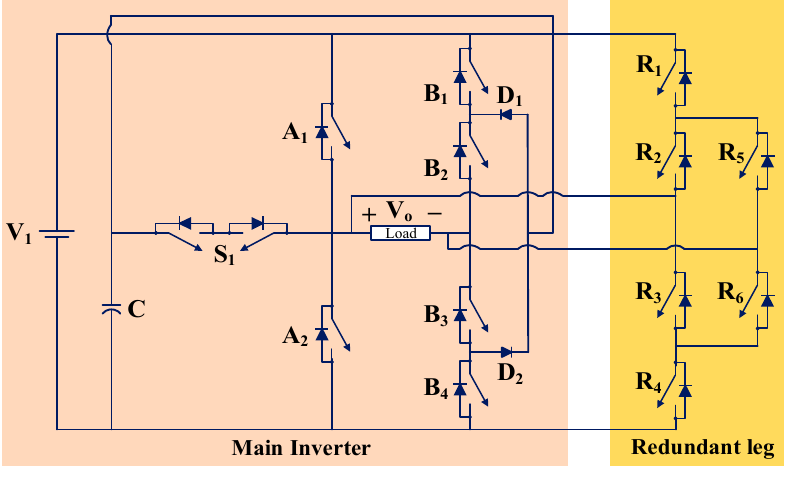
Figure 10. Single-phase five-level FT MLI (TP10) [50].